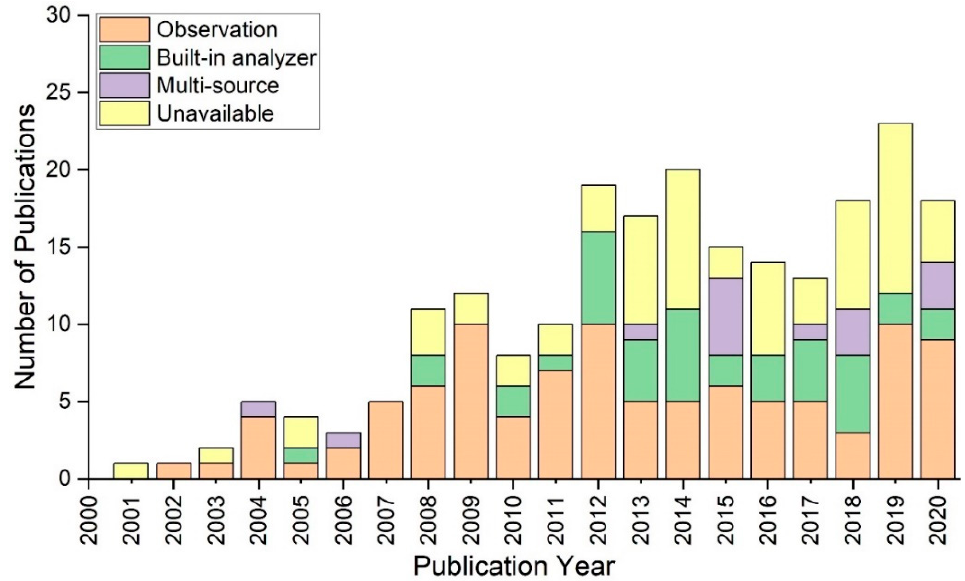
Figure 3. Number of studies interacting with behavioural data sources between 2001 and 2020.